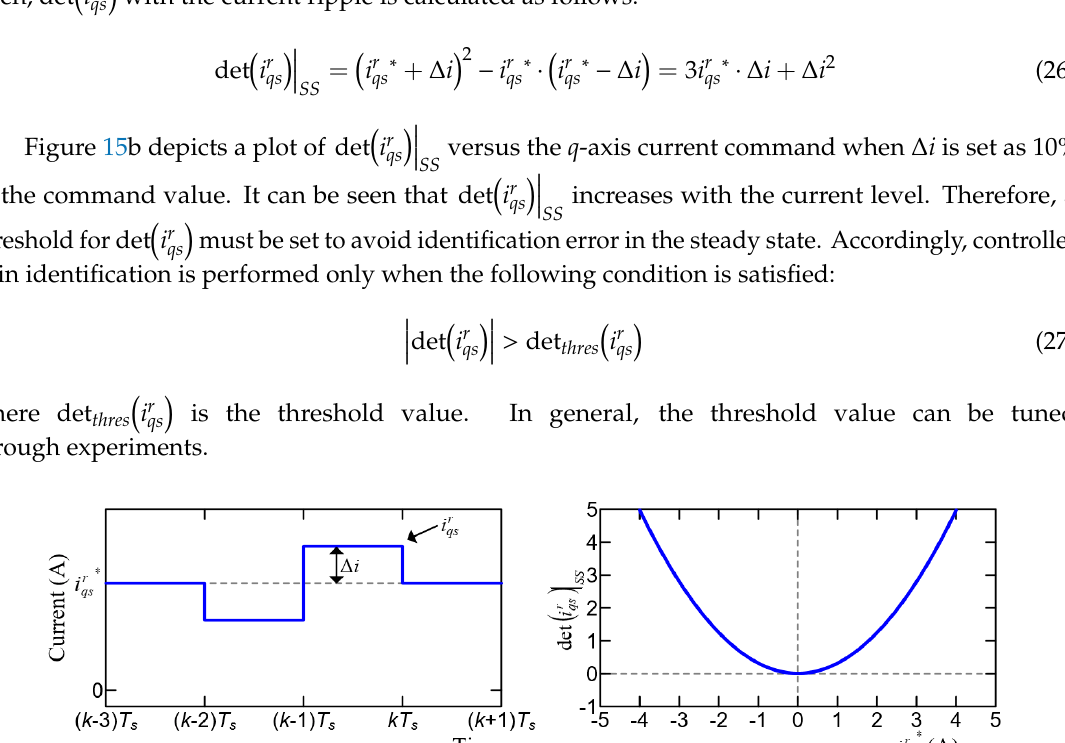
Figure15. ( a )Steady-state q -axiscurrentwithcurrentripple, and( b ) det Figure 15. ( a ) Steady-state q -axis current with current ripple, and ( b ) command.